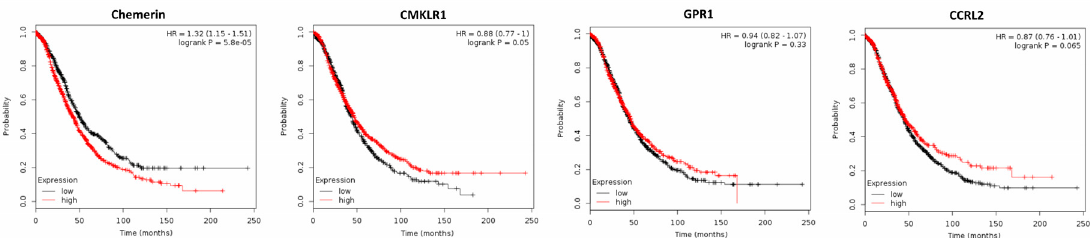
Figure 3. Kaplan–Meier diagrams showing the overall survival (OS) of 1656 ovarian cancer patients depending on expression of chemerin and its receptors CMKLR1, GPR1 and CCRL2 in tumor